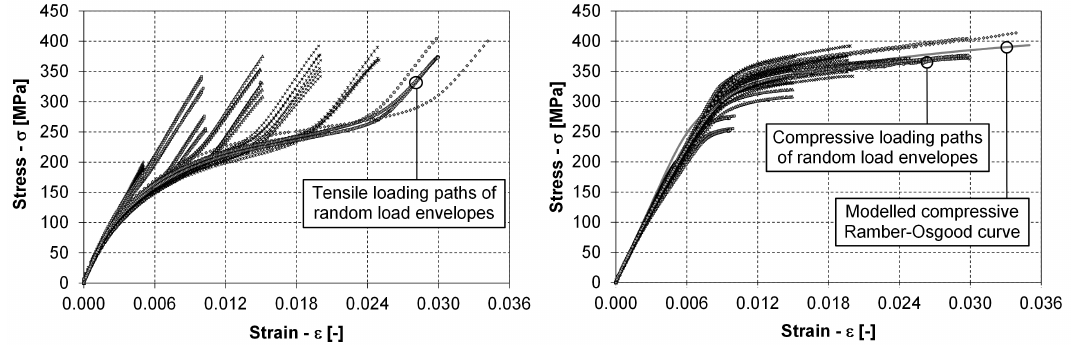
Figure 11. Measured tensile (left) and compressive (right) loading paths from the low-cycle fatigue tests.